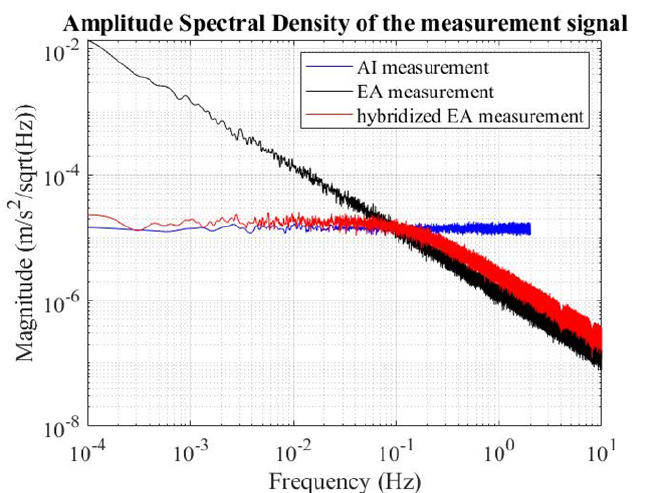
Figure 22. ASD of the acceleration noise, for the electrostatic accelerometer in black, the atom interferometer in blue, and the resulting combination in red. These data are provided by the developed hybrid instrument